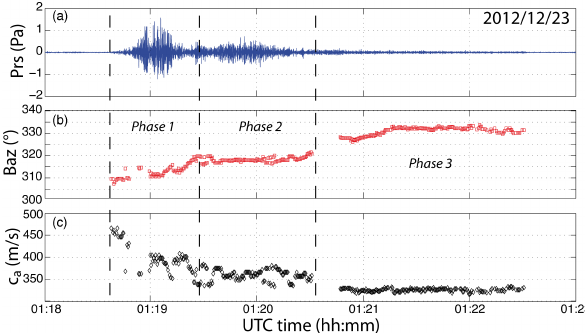
Figure 3. Infrasonic record (a) , back azimuth (b) and apparent ve- locity (c) of infrasound detections of the 23 December 2012 snow avalanche from Grosstal (Fig. 1). The vertical dashed lines define the three different phases of the signals which are further discussed in the